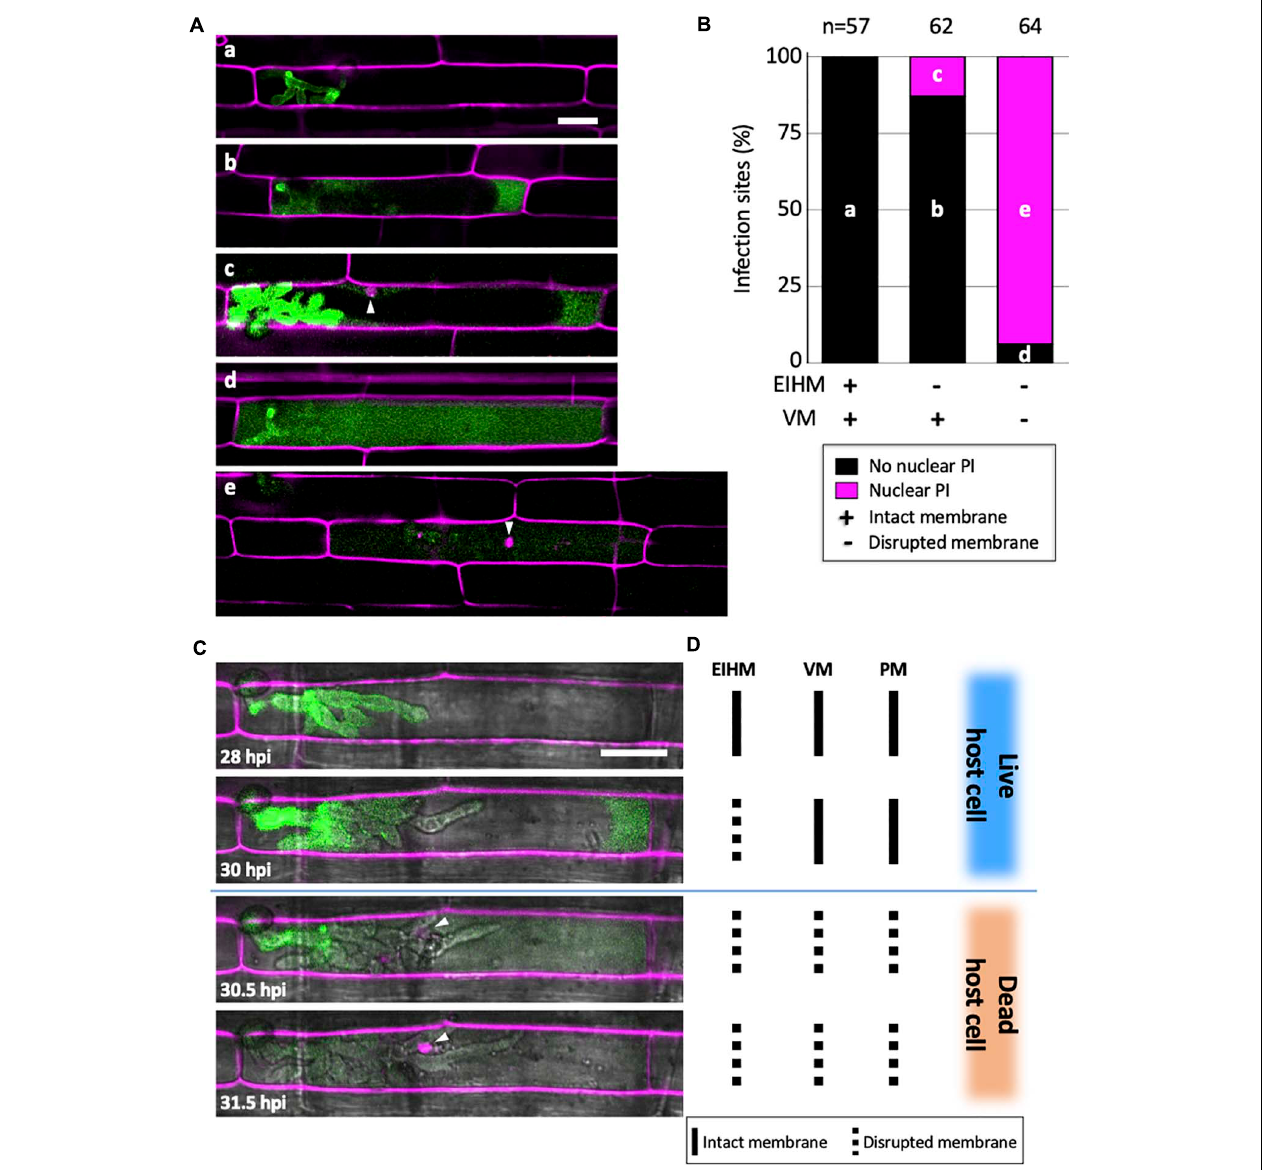
FIGURE 5 | Vacuole rupture indicates host cell death. (A,C) Rice cells invaded by M. oryzae CKF315 (sec-GFP; green) and stained with propidium iodide (PI; magenta). Shown are single plane confocal images of merged fluorescence (A) and merged bright-field and fluorescence (C) . White arrowheads indicate rice nuclei stained with PI. Bars = 20 µ m. (A) Representative images from the 183 infections from 29 to 34 hpi showing the five sec-GFP and PI localization patterns observed: (a) EIHMx-exclusive sec-GFP without nuclear PI stain, (b) sec-GFP spilled into the rice cytoplasm without nuclear PI stain, (c) same as (b) but with nuclear PI stain, (d) sec-GFP homogenized throughout the host cell lumen without nuclear PI stain, (e) same as (d) but with nuclear PI stain. (B) Graph showing the distribution of the five sec-GFP and PI fluorescence patterns shown in panel (A) for all 183 infections. Black bars and magenta bars represent infections without nuclear PI staining and with nuclear PI staining, respectively. (C) Time-lapse series of a PI-stained CKF315 infection from 21 to 31 hpi showing the typical progression of sec-GFP and PI fluorescence localization changes, consistent with quantitative results in panel (B) . Note that appearance of host nuclear PI fluorescence coincided with homogenization of host-localized sec-GFP fluorescence. (D) Schematic diagram summarizing the states of host membranes, corresponding to the infection shown in panel (C) . EIHM, extrainvasive hyphal membrane; VM, host vacuole membrane; PM, host plasma